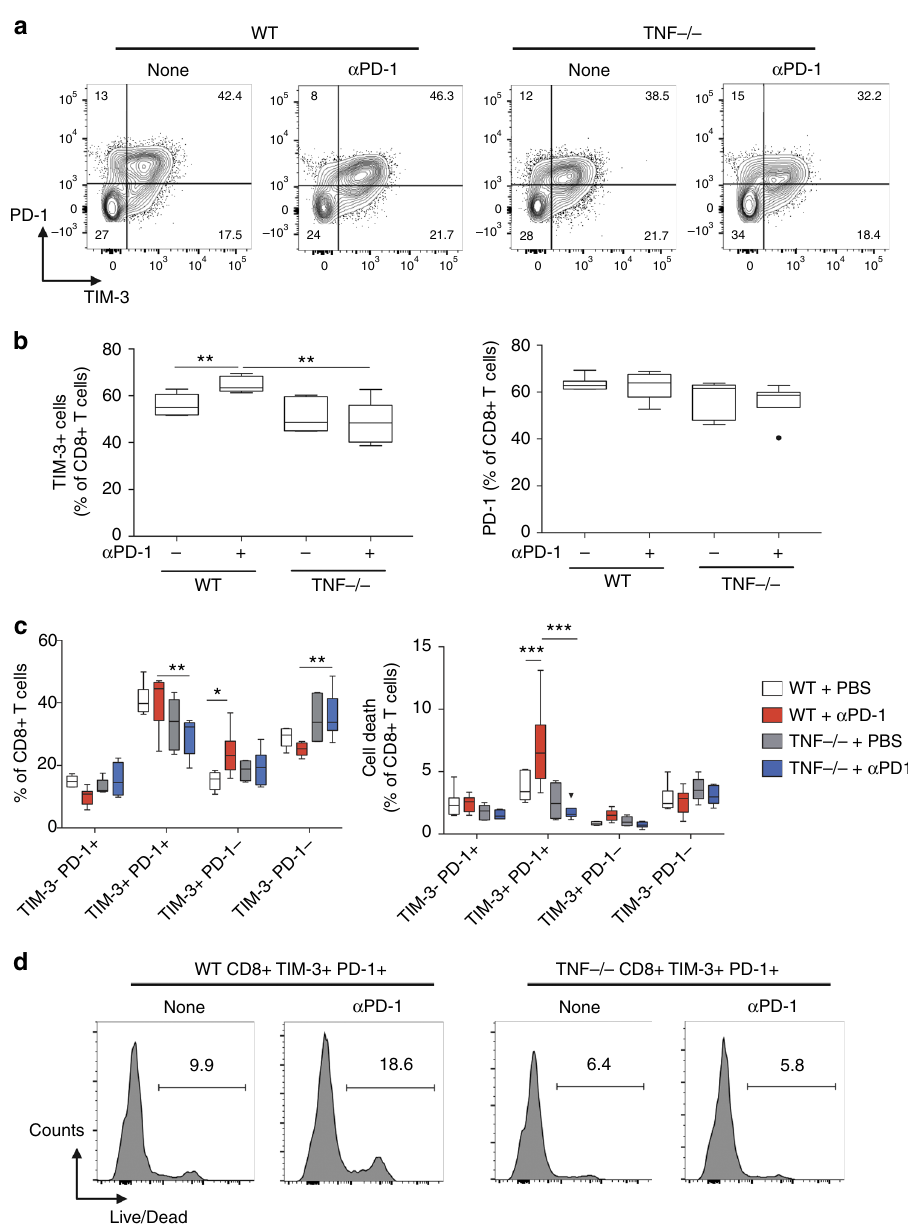
Fig. 3 Anti-PD-1 triggers TIM-3 expression on CD8+ TILs in a TNF-dependent manner. WT and TNF-de fi cient mice were injected as described in the legend to Fig. 2. TIM-3 and PD-1 expression on CD8+ TILs was determined by fl ow cytometry at day 10. a Representative staining; values indicate the proportion of cells in the different quadrants. b Quanti fi cation of the proportion of TIM-3+ (left panel) and PD-1+ (right panel) among CD8+ TILs. c Quanti fi cation of the proportion of CD8+ TILs expressing or not TIM-3 and PD-1 (left panel), and proportion of cell death among CD8+ T cells of the indicated populations (right panel). Values in 5 – 6 mice per group from one experiment are represented as Tukey boxes (b: Student ’ s t -test: ** p < 0.01; c: two-way Anova: *** p < 0.001). d Representative histograms of live/dead staining in CD8+ TILs expressing both TIM-3 and PD-1. Values are percentages of dead cells among the TIM-3+ PD-1+ CD8+